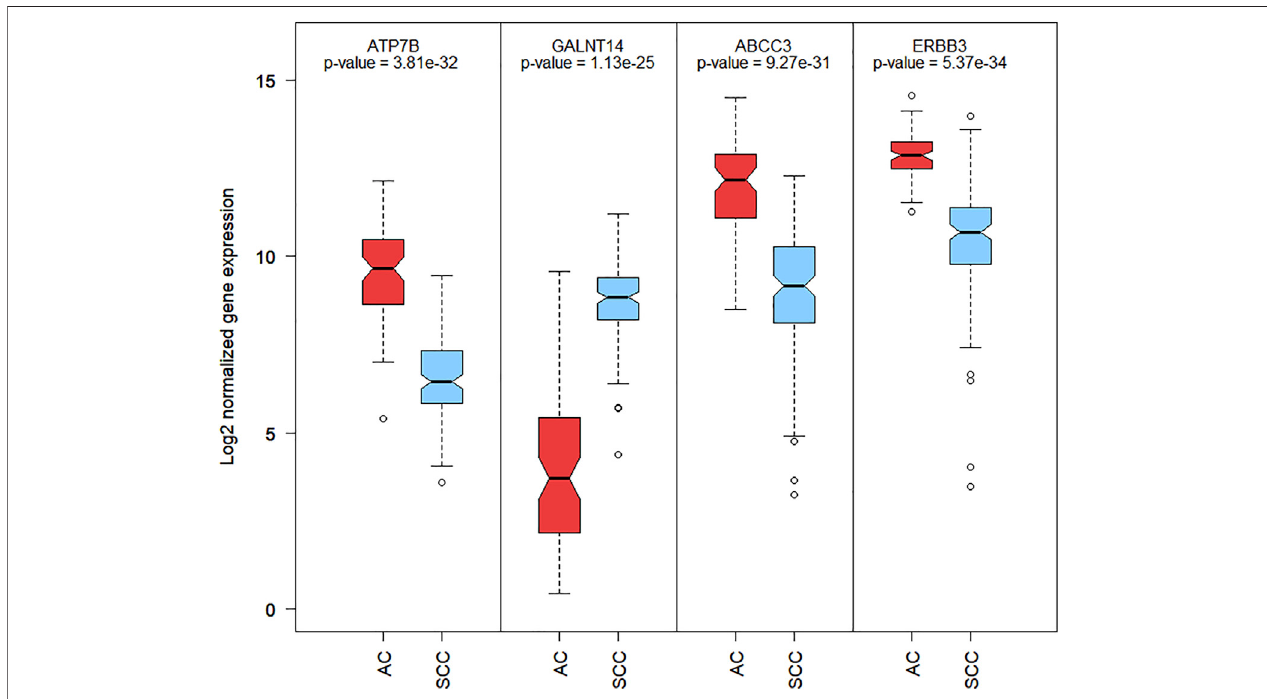
FIGURE 3 | Network of drugs important for chemotherapy in patients with esophageal cancer, and genes identi fi ed from the set of the most informative biomarkers predictive of the two main histological subtypes of esophageal cancer.